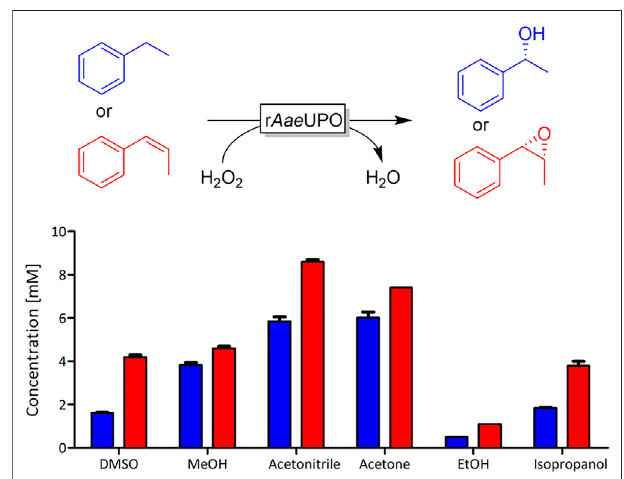
FIGURE 1 | r Aae UPO-catalyzed oxyfunctionalization of ethylbenzene (blue) and cis - β -methyl styrene (red). Reaction conditions: [substrate] = 10 mM, [KPi, pH 6] = 100 mM, [co-solvent] = 20 vol%, [r Aae UPO concentrated supernatant] = 1 μ M, and [H 2 O 2- feed] = 4 mM/h; reaction time = 2.5 h for ethylbenzene and 3 h for cis - β -methyl styrene, total volume 0.5 mL, 25 ° C, 600 rpm, duplicate